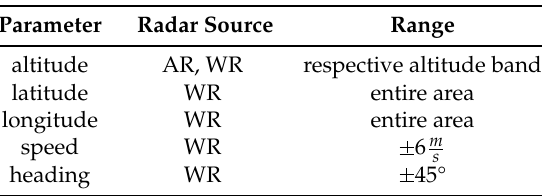
Table 6. Parameters randomized for the Monte Carlo replications and the ranges within which the randomizations were carried out. AR: avian radar; WR: weather radar. Source: [14].